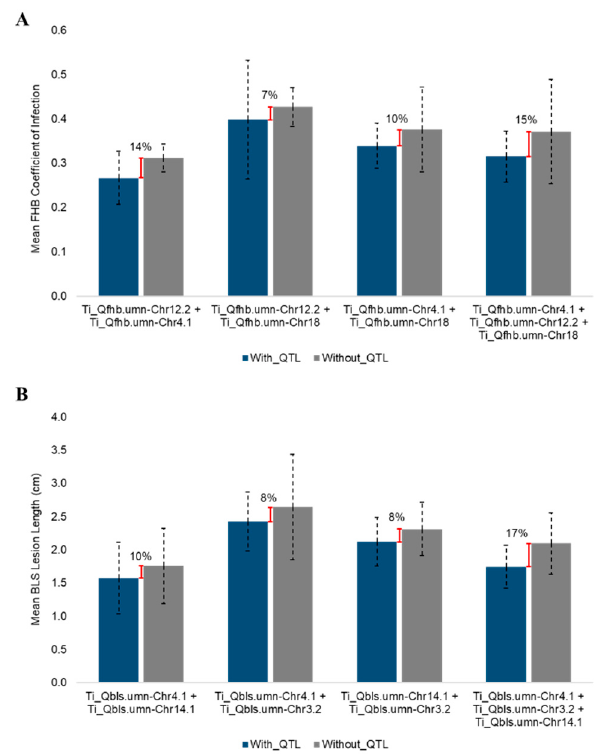
Figure 5. Reductions in ( A ) FHB and ( B ) BLS disease levels in A77-3 × C20-7 F 1 genets containing two or three QTL models. For each disease, genets containing QTL with the highest R 2 values observed in each environment were identified, with the exception of Ti_Qfhb.umn-Chr4.1 . This QTL was the second largest in FHB17 and was used since both FHB16 and FHB17 shared the largest QTL, Ti_Qfhb.umn-Chr4.1 , in both environments. Red bars and accompanying text show the percentage reduction in disease when QTL are combined. Error bars represent the standard deviation of disease